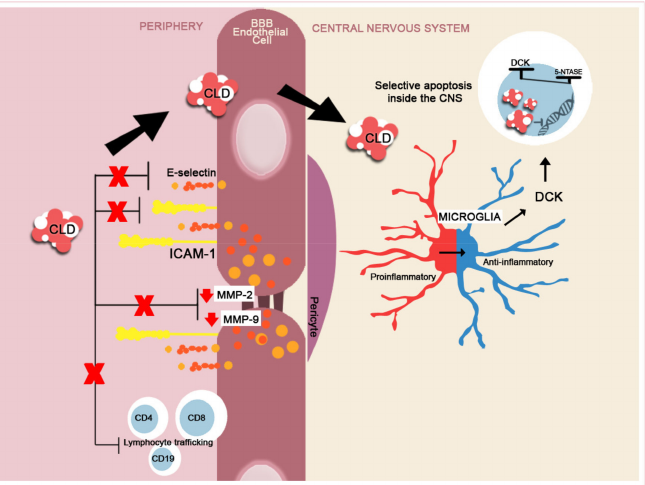
Figure 5. A brief schematic representation of CLD’s mechanism of action. In the peripheral compartment, CLD reduces the expression of adhesion molecules, ICAM-1 and E-selectin and reduces the expression of MMP-2 and -9 [136–139], thus inhibiting the lymphocyte transition into the CNS. CLD is internalized into the cells and undergoes specific phosphorylation by deoxycytidine kinase (DCK). Immune cells, the lym- phocytes being the most susceptible, contain reduced levels of phosphatases 5-nucleotidases (5-NTASE), which will only partially dephosphorylate the accumulated CLD, leading to selected apoptosis and not cellular death (ratio of DCK to 5-NTASE) [140,141]. In MS, CLD selectively reduces Th and B lymphocyte numbers and trafficking from the periphery [142]. CLD reduces the activation of proinflammatory microglia (M1) and shifts the activity towards an anti-inflammatory (M2) phenotype